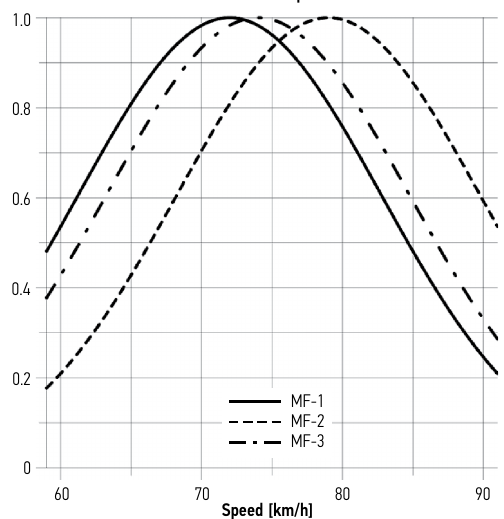
Fig. 4. Membership Functions (MF) of the input variable Speed ( Sp